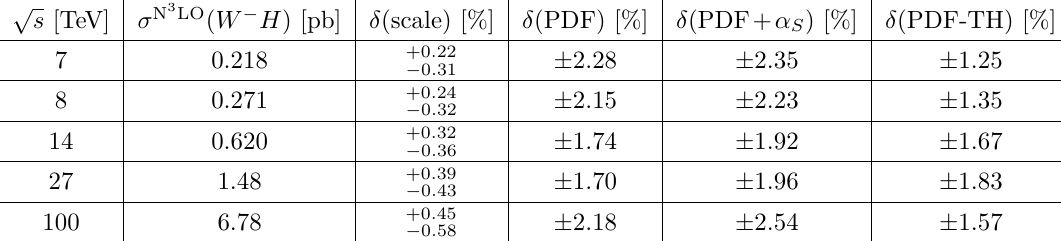
Table 11 . The same as in table 8, but with µ 0 = M H + M W .